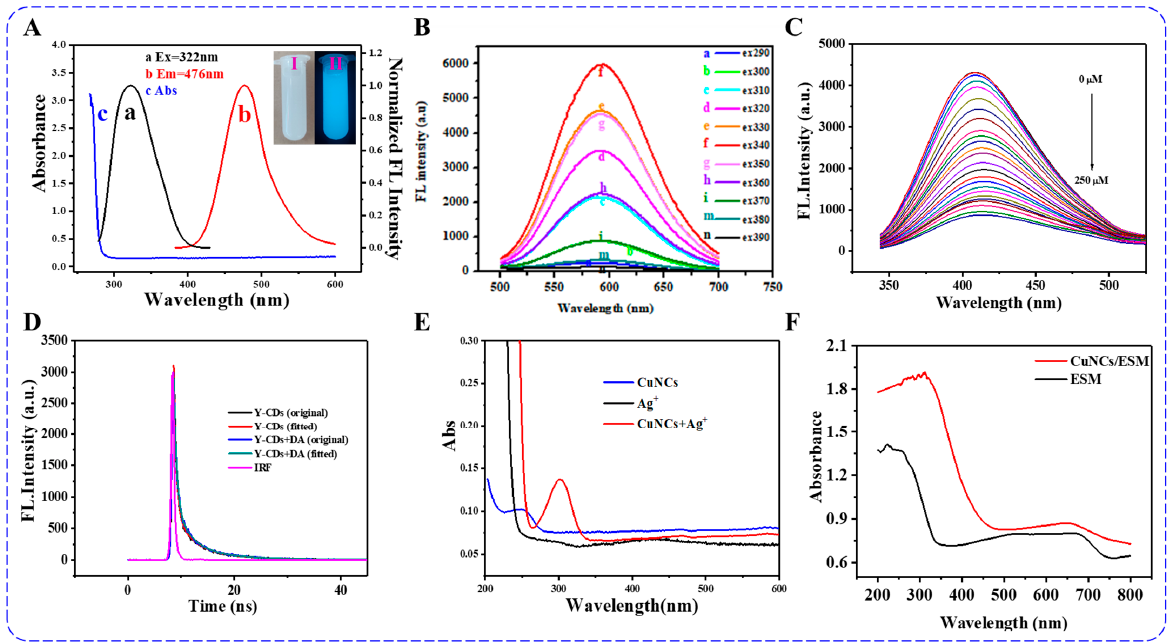
Figure 3. ( A ) Excitation and emission spectra of MMI-CuNCs (illustration: photos of MMI-CuNCs under daylight and UV lamp) [53], Copyrights from American Chemistry Society, 2022. ( B )The